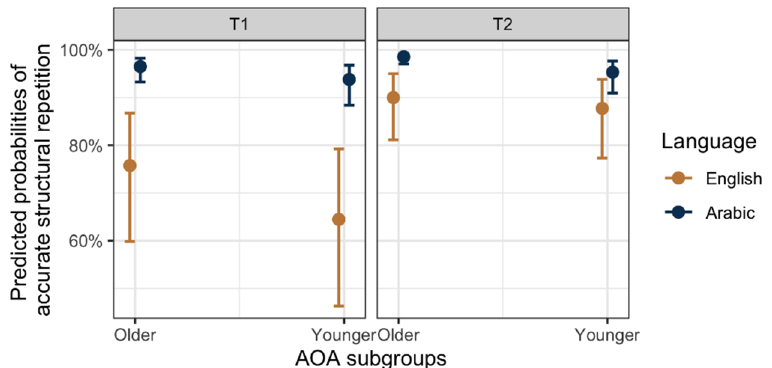
Figure 4. Marginal effects of the Language*Time*AOA interaction in the logistic mixed-effects model comparing performance in the two languages at the two times by the two AOA subgroups. The point indicates the predicted average probability of a morphosyntactic structure being repeated accurately according to Language, Time, and AOA subgroup. The whiskers indicate the 95% confidence interval.